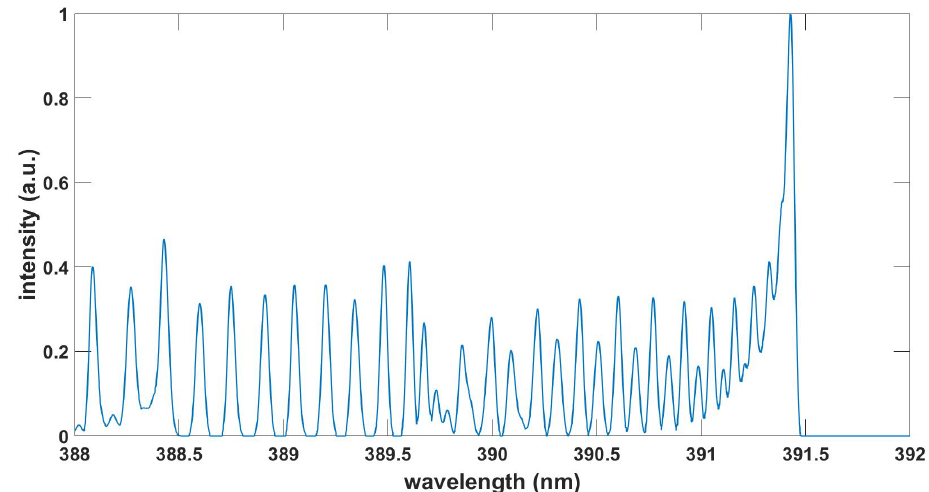
Figure 5. Computed N + spectrum, ∆ v = 0, δ λ = 0.035nm, T = 5.1 kK. 2